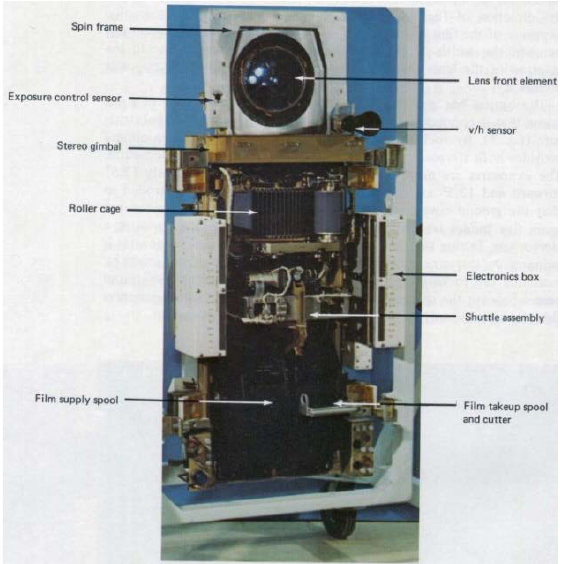
Figure 4: Apollo Panoramic Camera with cover removed (NASA).